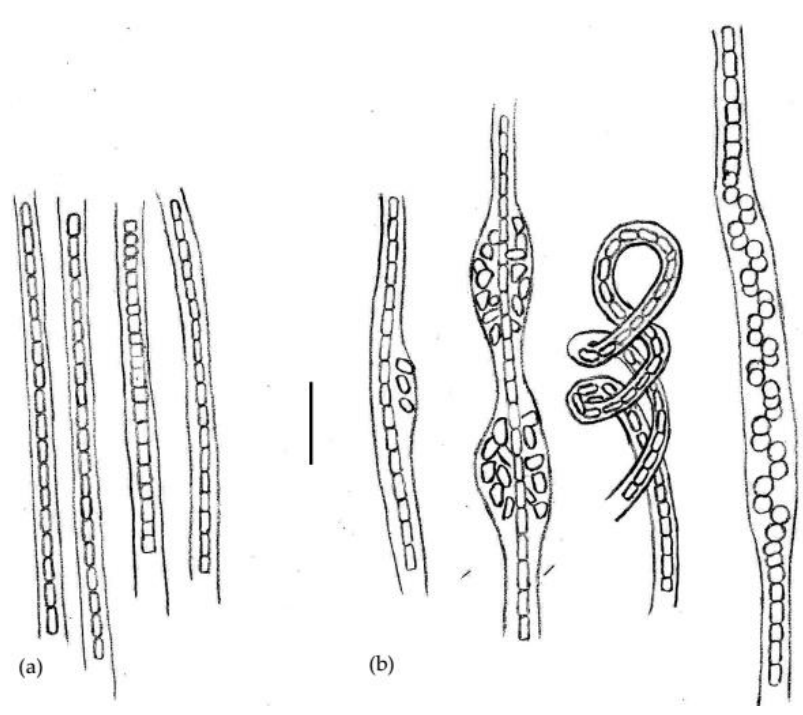
Figure 2. Line drawings of Nodosilinea hunanesis. ( a ) Single trichomes with sheaths. ( b ) Trichomes with nodules, and filaments forming loose spirals. Scale bars: 10 μm.